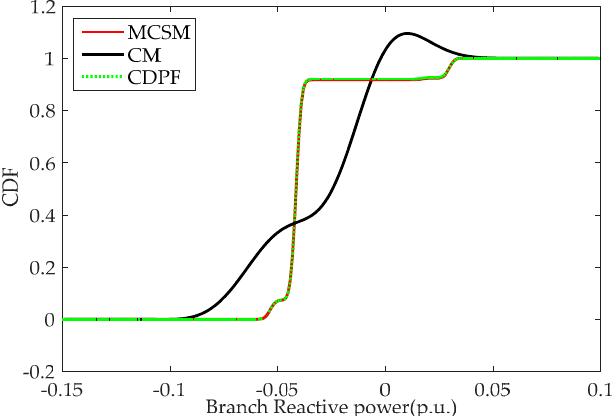
Figure 5. The CDF of the reactive power at branch 20 (13–14) in an IEEE 14-bus power system.